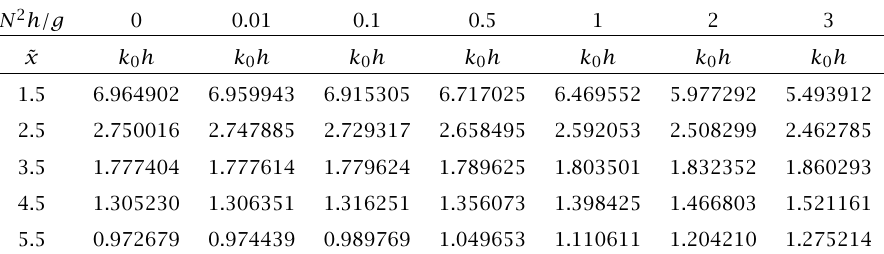
Table 5.1 . ˜ t = 8, (cid:5)/h = 0 .